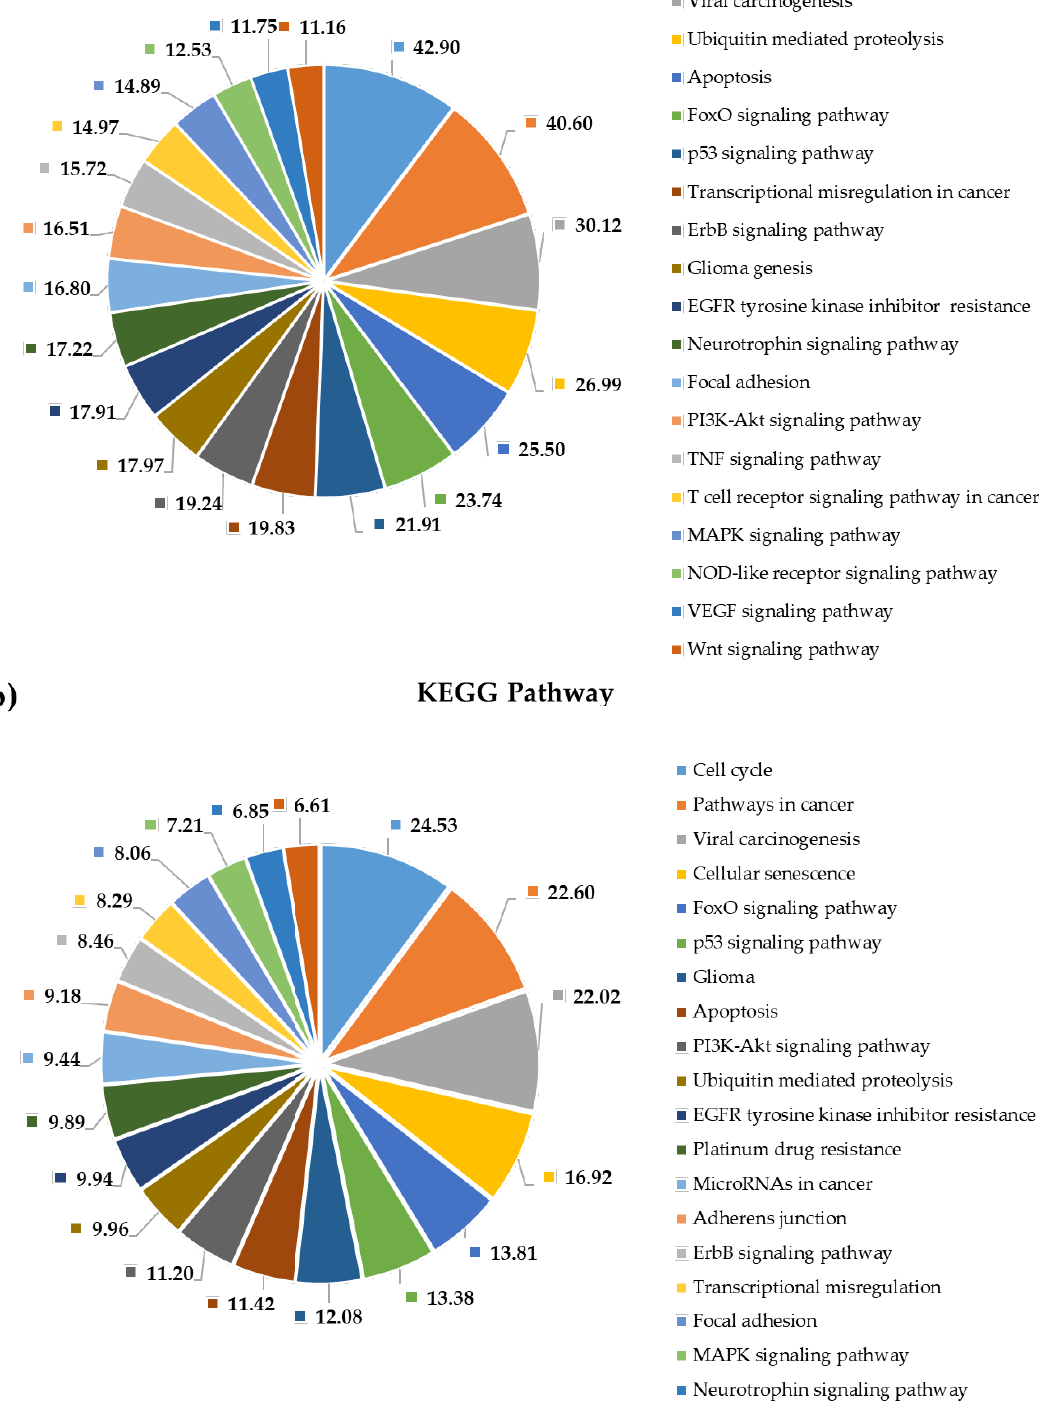
Figure 10. KEGG pathway–based general ( a ) and cortex-specific ( b ) functional pathway enrichment annotation of all target genes of differentially expressed miRNAs applying the NetworkAnalyst tool. Significance of the selected (?) pathways are characterized by their FDR values shown inside the chart sections.